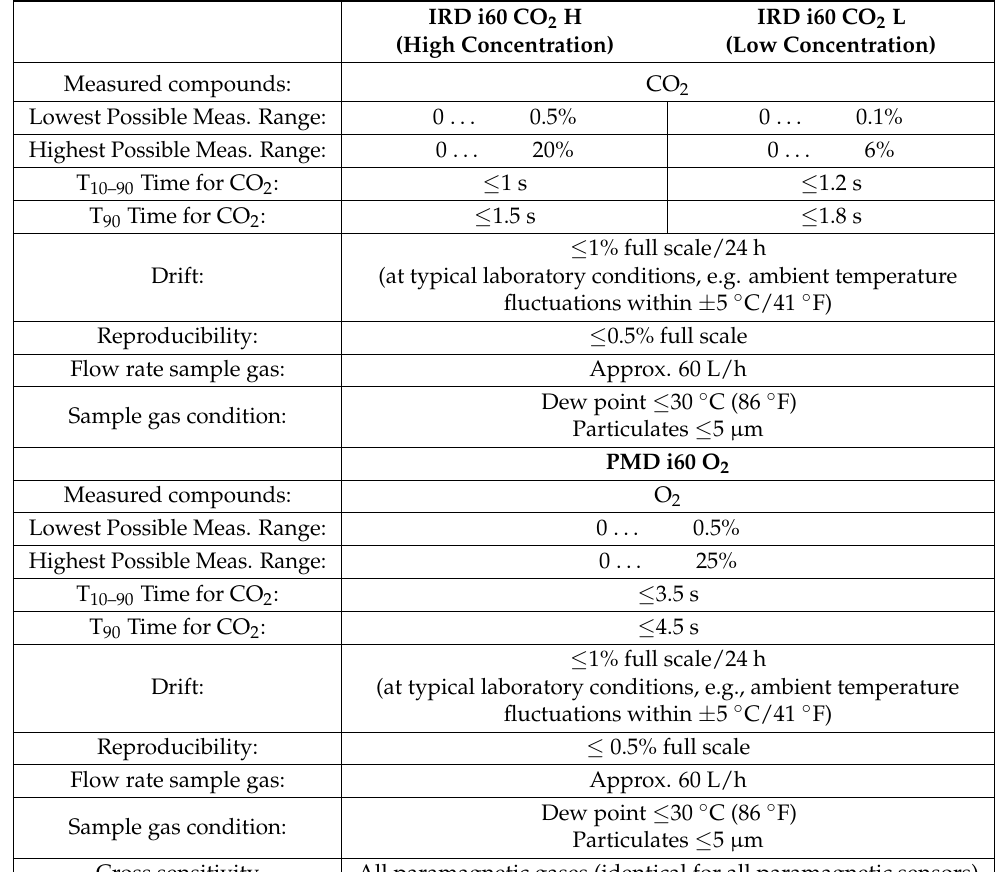
Figure 3. Representation of the steady-state tests ( a ) and the transient test ( b ) that constitute dataset 1. Details on the test bench facility used for the acquisition of dataset 1 and on the experimental procedure can be found in [11] and are not reported here for the sake of brevity, but the accuracy and the characteristics of the infrared detector (IRD) and paramagnetic oxygen detector (PMD) sensors used for measurement of the intake CO 2 and O 2 concentration, respectively, are reported in Table 1. The instruments are embedded in an AVL AMAi60 gas analyzer. Table 1. Characteristics of the IRD and PMD